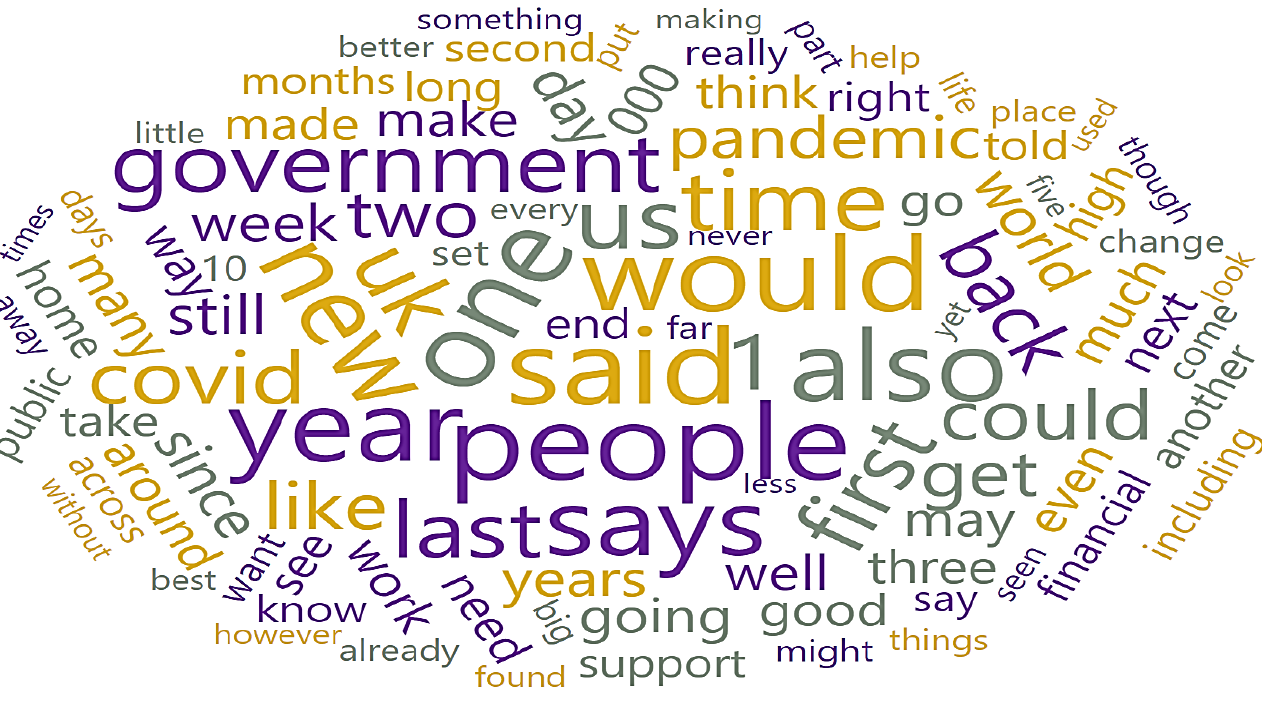
Figure 6. Sentiment Representation through Word Cloud.